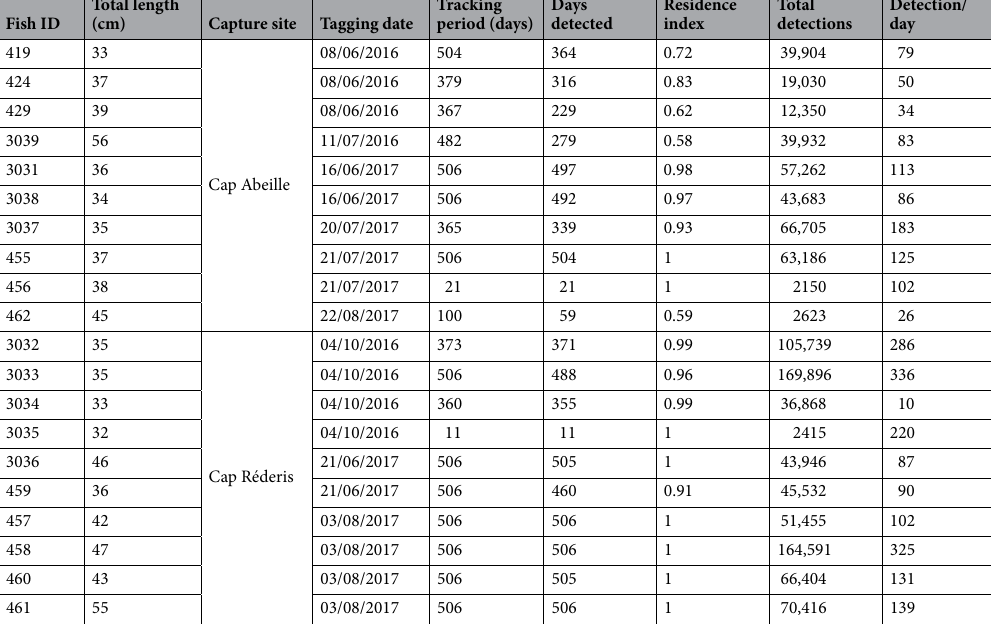
Table 1. Summary of the sampling and acoustic detection information of the studied fish (non-averaged data). Residence index represents the proportion of days that each individual remained within the detection array. Fish ID fish identification